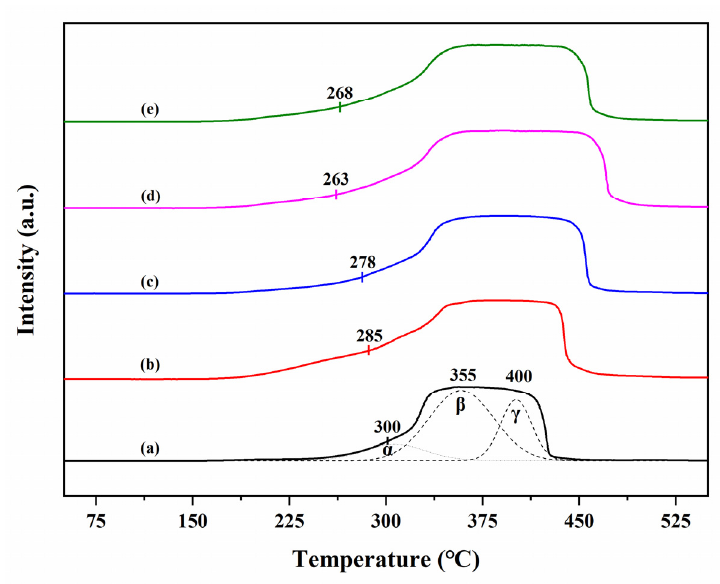
Figure 8. H 2 -TPR profiles of ( a ) OMS-2, ( b ) 1Ni/OMS-2, ( c ) 3Ni/OMS-2, ( d ) 5Ni/OMS-2, and ( e ) 10Ni/OMS-2.